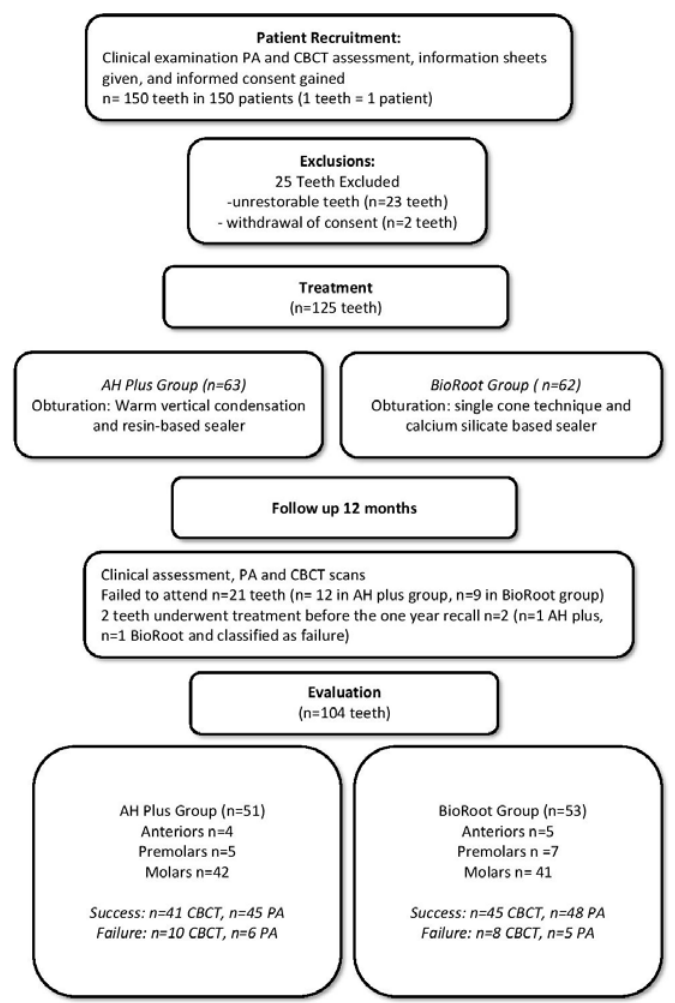
Figure 1. Flow diagram of the study recruitment, follow-up, and results.